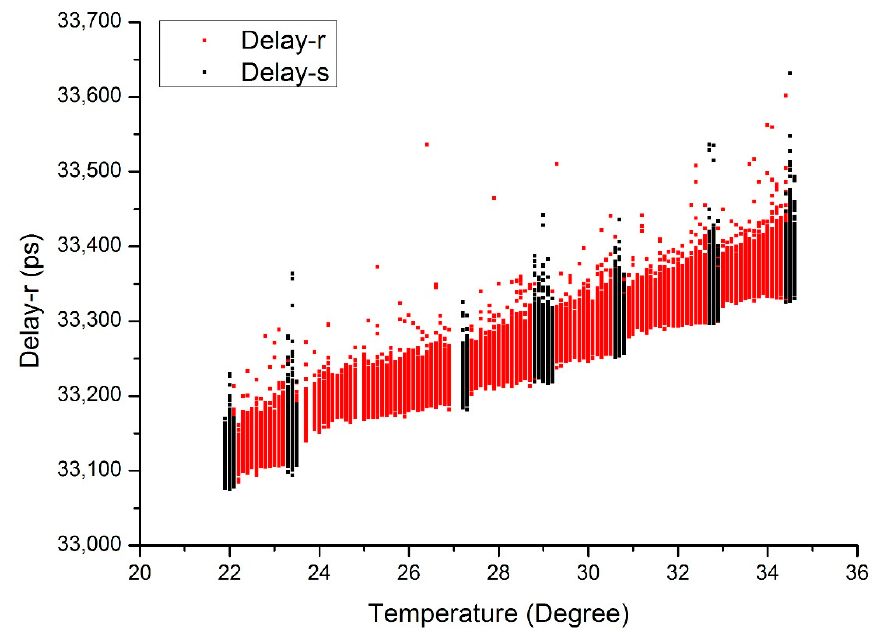
Figure 3. Propagation delay vs. environment temperatures. (The black dots represent the data of the temperature stable period and the red dots represent the temperature rising